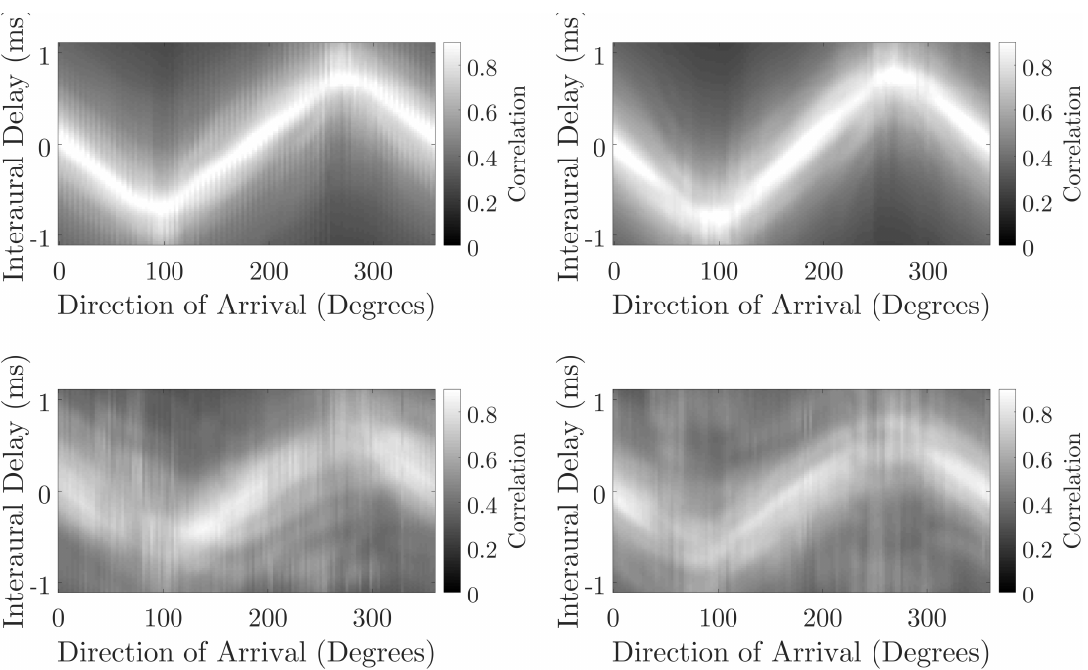
Figure 9. Comparison of interaural cross correlation across the direction of arrival for the KEMAR measured direct sound ( top left ), KEMAR measured reflection ( bottom left ), KU100 measured direct sound ( top right ) and KU100 measured reflection ( bottom right